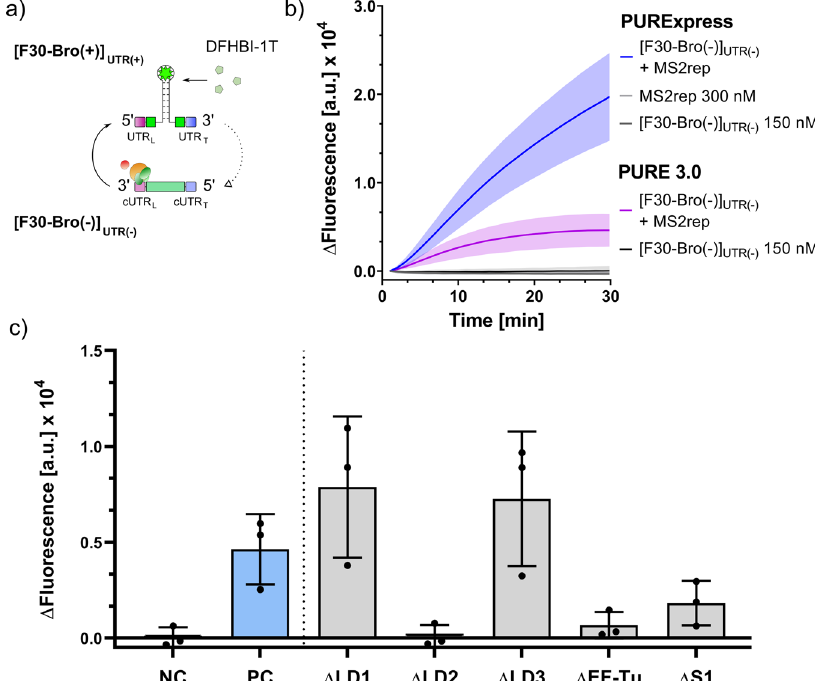
Fig. 2 Effect of different PURE co-factors on [F30-Bro( + )] UTR( + ) synthesis by MS2rep. a The broccoli aptamer (F30-Bro) for fl uorescence readout is incorporated into a replication scaffold based on the MS2 UTRs. Using [F30-Bro( − )] UTR( − ) as template, the MS2 replicase complex synthesises [F30- Bro( + )] UTR( + ) and the broccoli aptamer therein binds fl uorogenic DFHBI-1T. b Replicase activity in commercially available PURExpress (blue), in an in- house PURE 3.0 (purple), as well as in negative controls either lacking MS2rep (black & dark grey) or the RNA template (light grey). Reactions were incubated at 37 °C for 30 min and fl uorescence was measured every minute. c Endpoint fl uorescence of depletion permutation assay for in-house PURE- based replication system, programmed with 50 nM [F30-Bro( − )] UTR( − ) RNA. Reactions contained all components except MS2rep (NC, dark grey), all components (PC, blue), or all components except the indicated ones. Fluorescence was measured every minute over a 30-min time course at 37 °C. Error bars indicate standard deviation, based on three independent technical